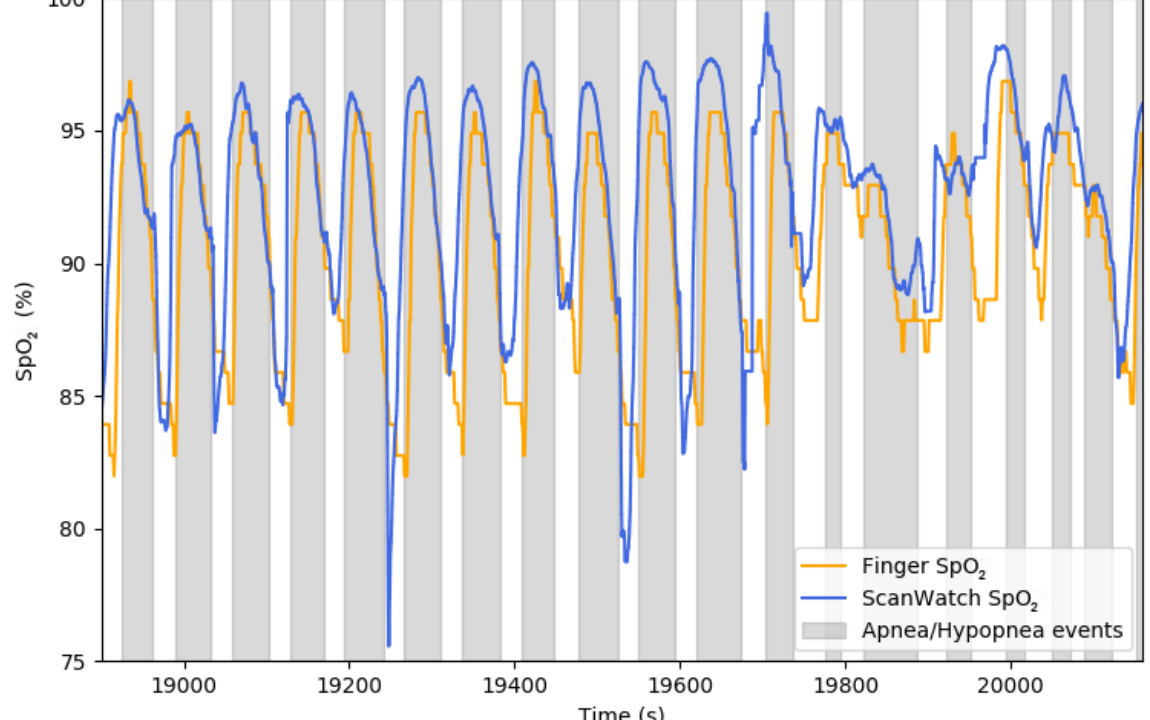
Figure 6. SpO 2 measured by ScanWatch and a finger pulse oximeter during apnea/hypopnea